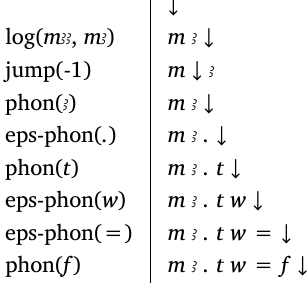
Figure 5: Computation for